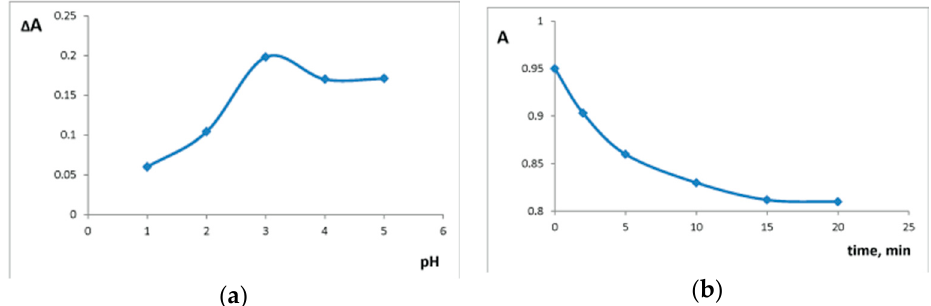
Figure 6. ( a ) The effect of pH on Δ A = A 0 − A 200 , where A 0 is Si-Ti/ECR absorbance in absence of oxalate and A 200 is Si-Ti/ECR absorbance in presence of 200 mg/L oxalate ( λ 570 nm, time of contact is 15 min); ( b ) kinetics of the interaction of Si-Ti/ECR with 200 mg/L oxalate solution ( λ 570 nm, pH 3.0). m/V = 0.10 g/ 5.0 mL.